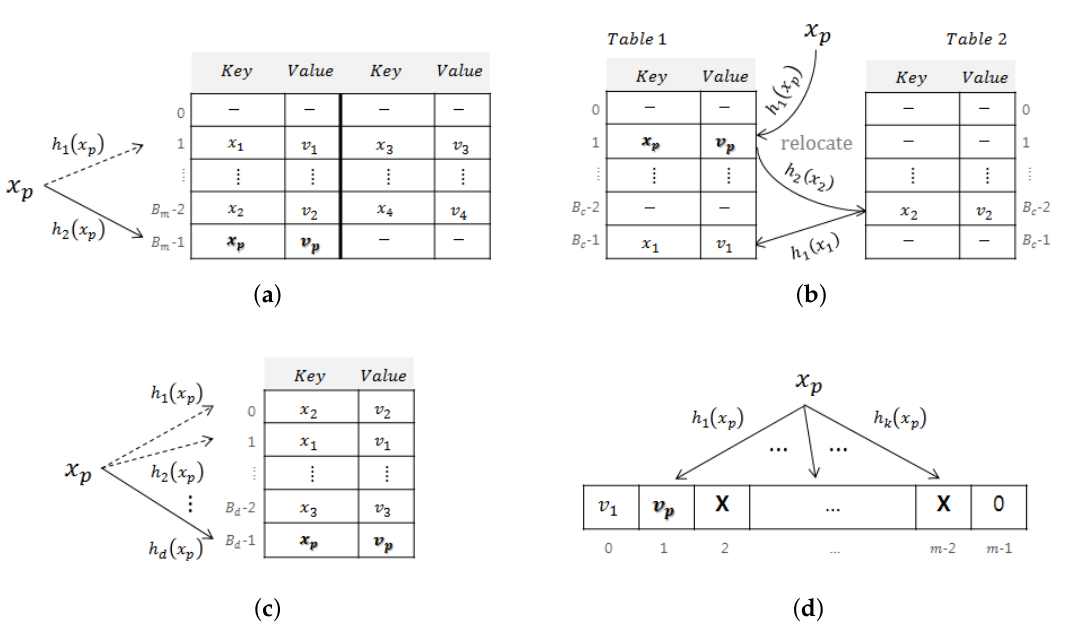
Figure 1. Hash-based key-value data structures: ( a ) Multi-hash table; ( b ) Cuckoo hash table; ( c ) d -left hash table; ( d ) Functional Bloom